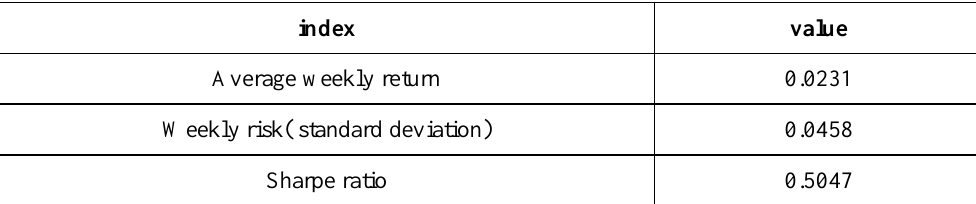
Table 6. Relative robust risk parity portfolio performance on test